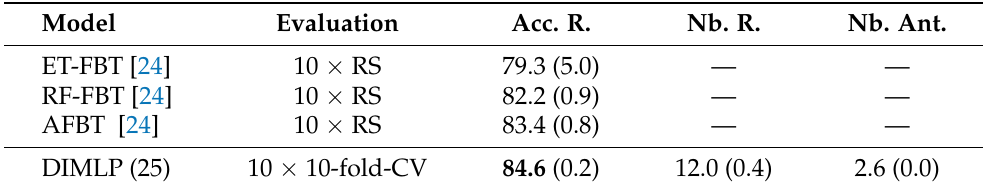
Table 15. Other results on the “Mammographic” dataset. A bold number represents a highest average accuracy of the